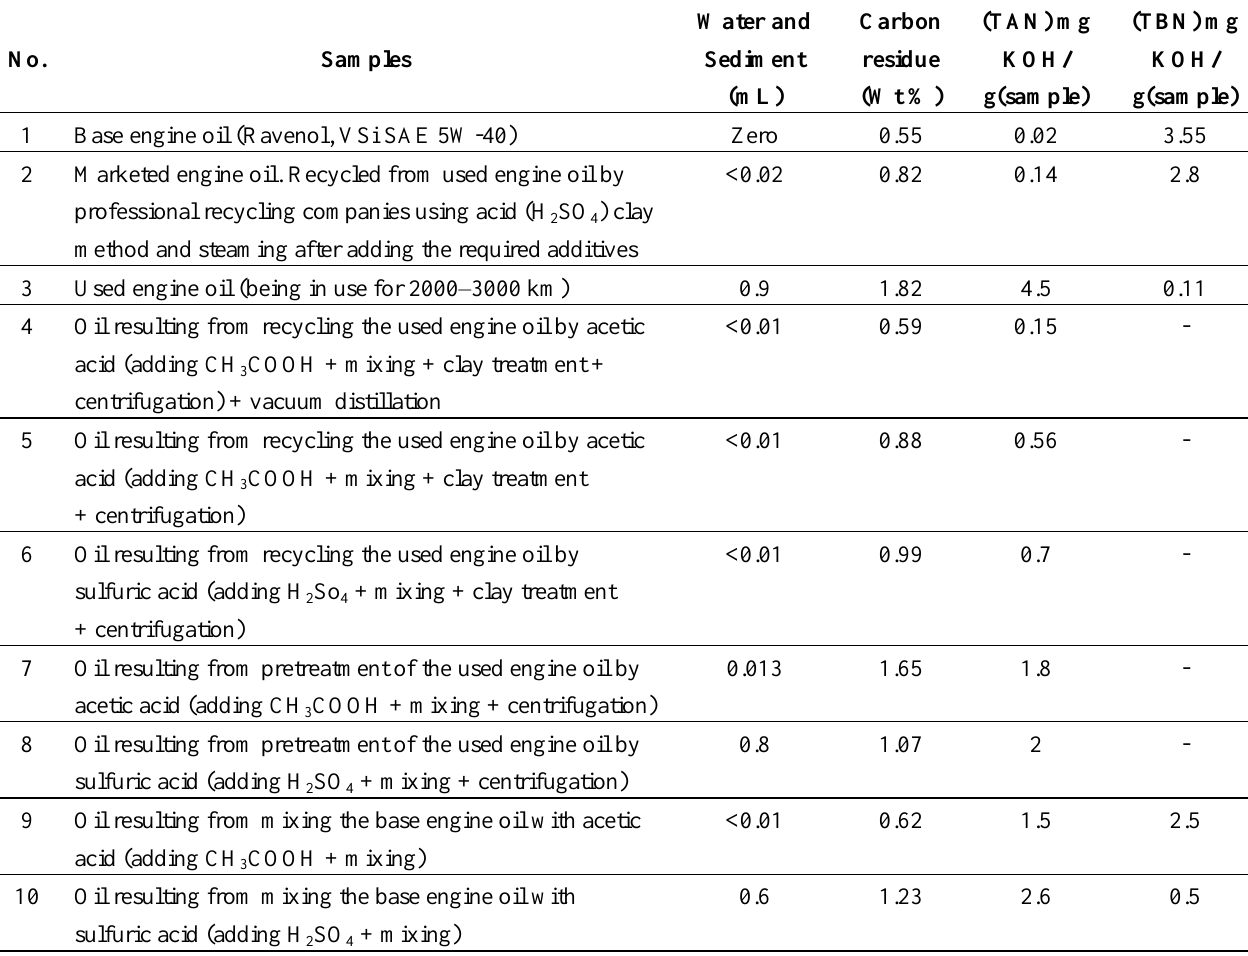
Table 3. Analysis results of sediments and acidity of different